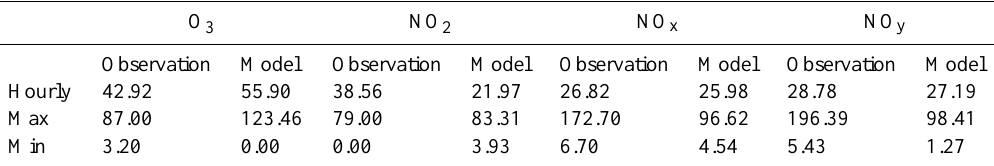
Table 3. Comparisons between the modeled hourly, max and min data against observations of surface O 3 , NO 2 , NO x and NO y during August 5–31,